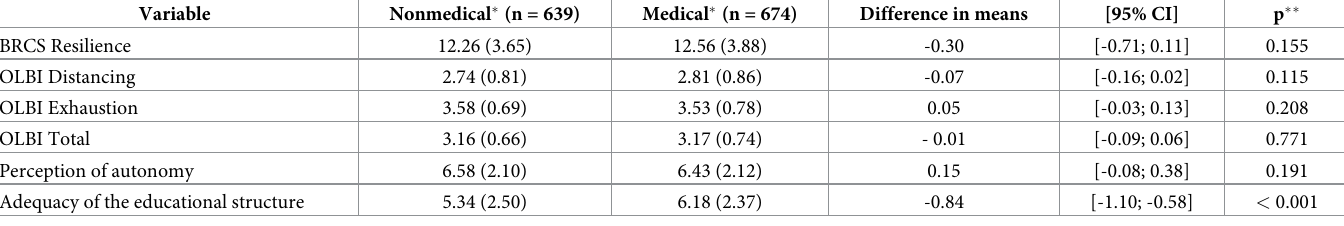
Table 2. Scores for medical and nonmedical residents on the instruments used to assess resilience, distancing, exhaustion, burnout, perception of autonomy and adequacy of the educational structure.